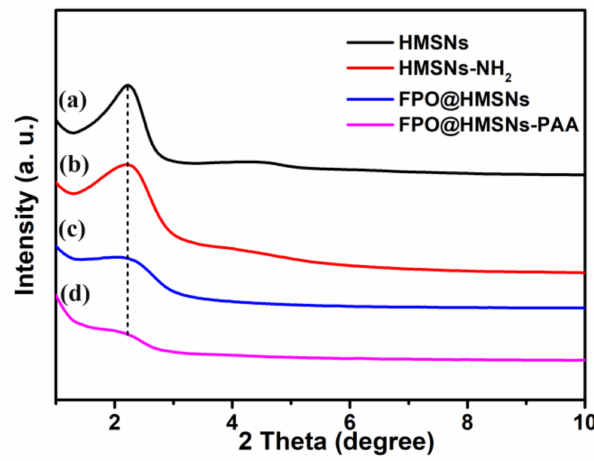
Figure 2. Low-angle XRD patterns of ( a ) HMSNs; ( b ) HMSNs-NH 2 ; ( c ) FPO@HMSNs; and ( d